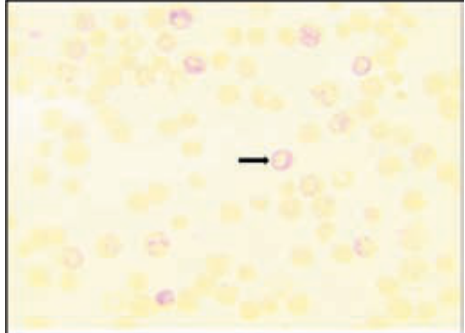
Fig. 4. Reticulocytes, 1000 X magnification, Azure B stain